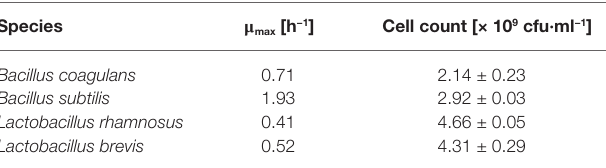
TABLE 1 | Cell count of probiotic bacteria after 24 h during the fermentation of crude FOS.